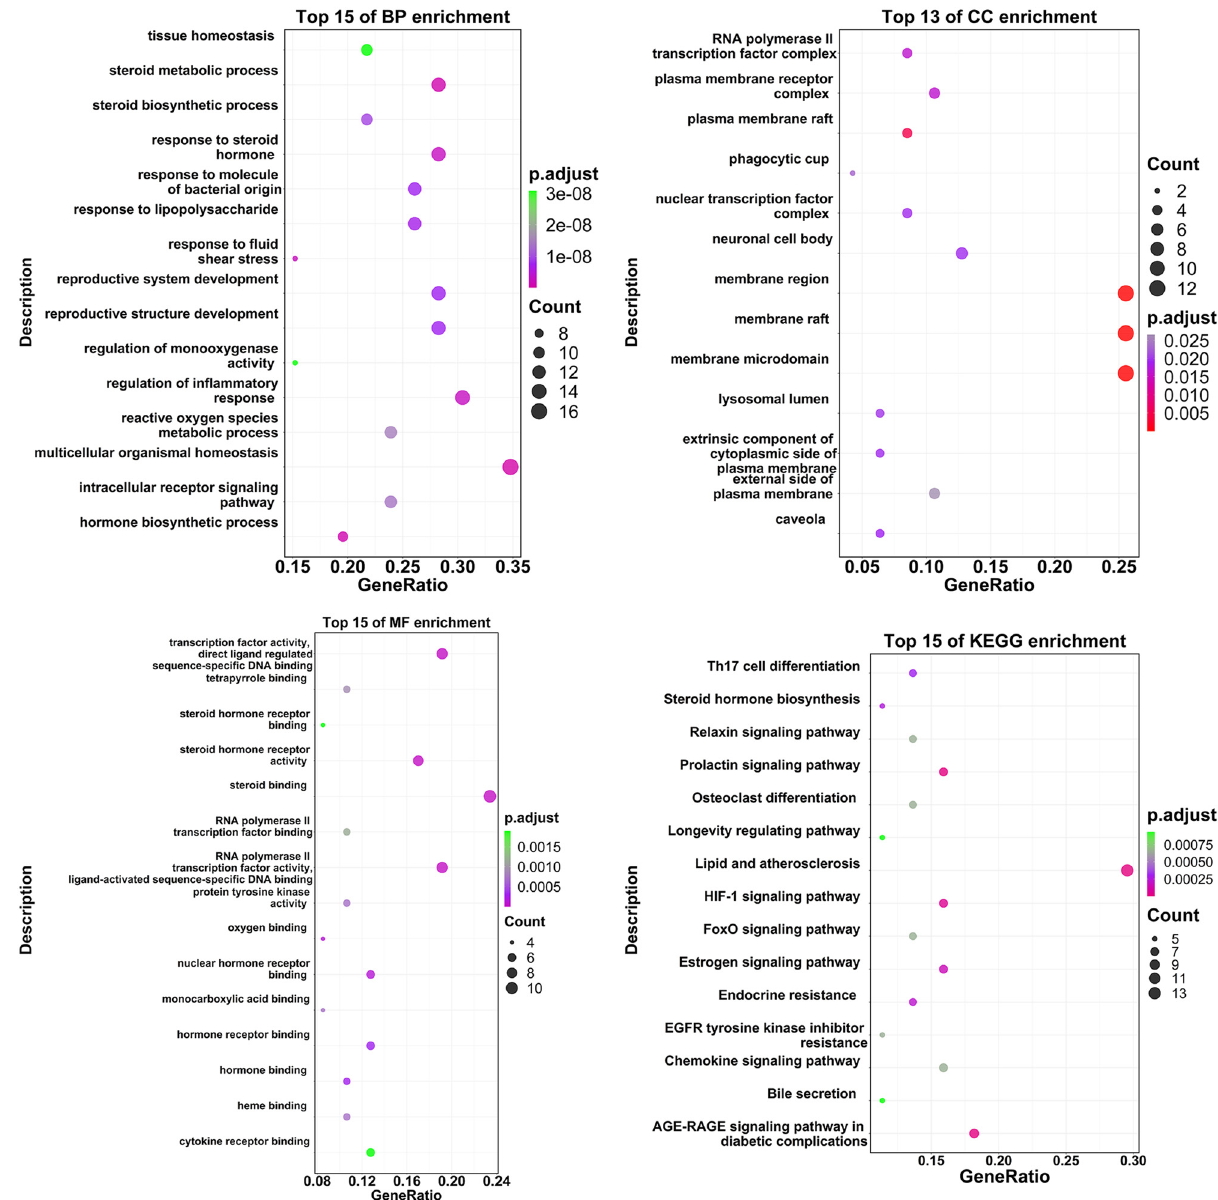
Figure 1: The representative GO terms or KEGG pathways for potential targets of β - ecdysone treating